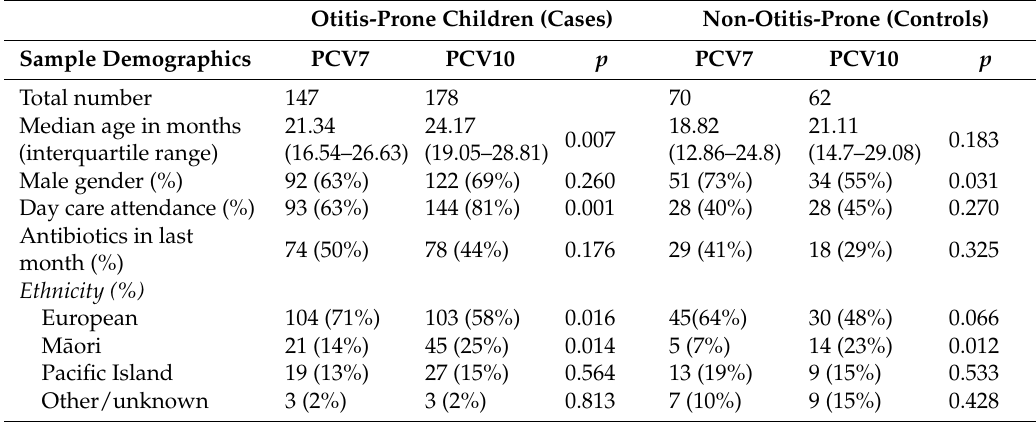
Table 3. Comparison of demographics for otitis-prone cases and non-otitis-prone controls between vaccine